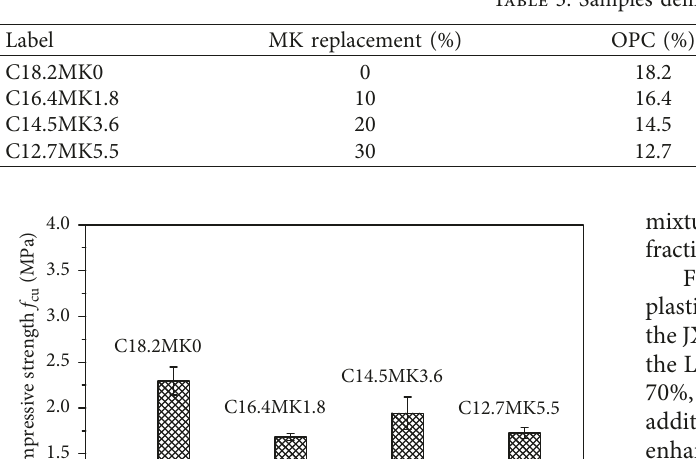
Table 3: Samples definition.